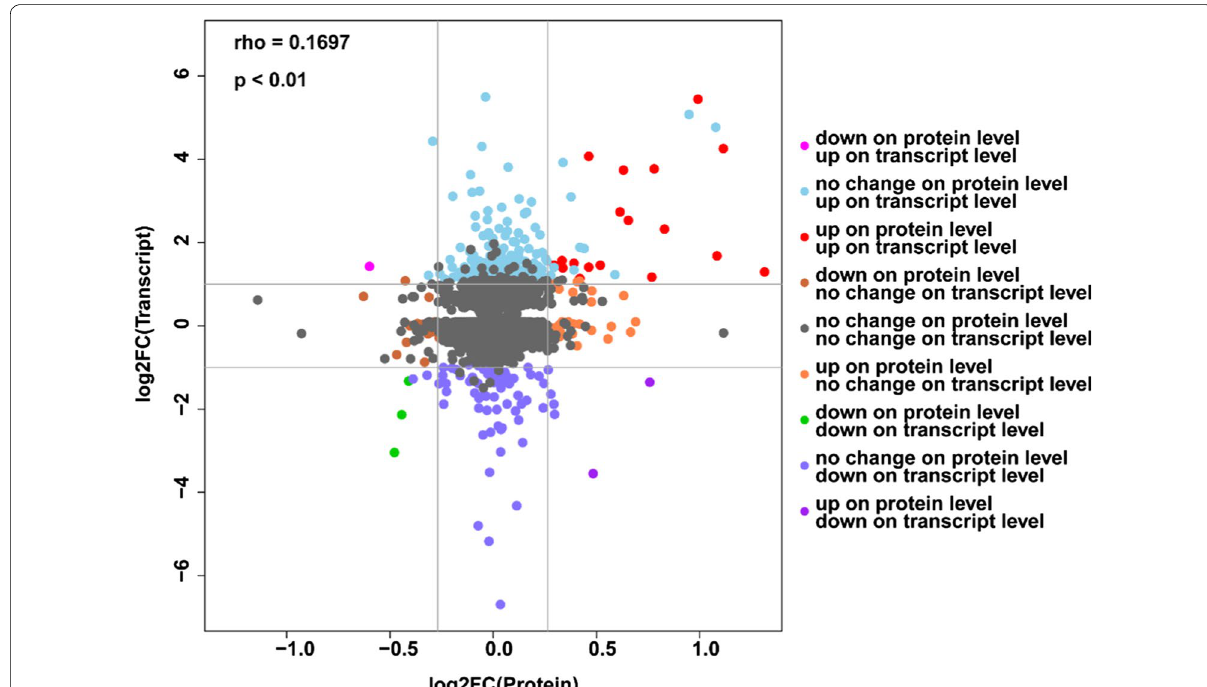
Fig. 6 Correlation analysis of proteomic and transcriptomic data (10-day samples). Differentially expressed mRNAs or proteins are represented by solid